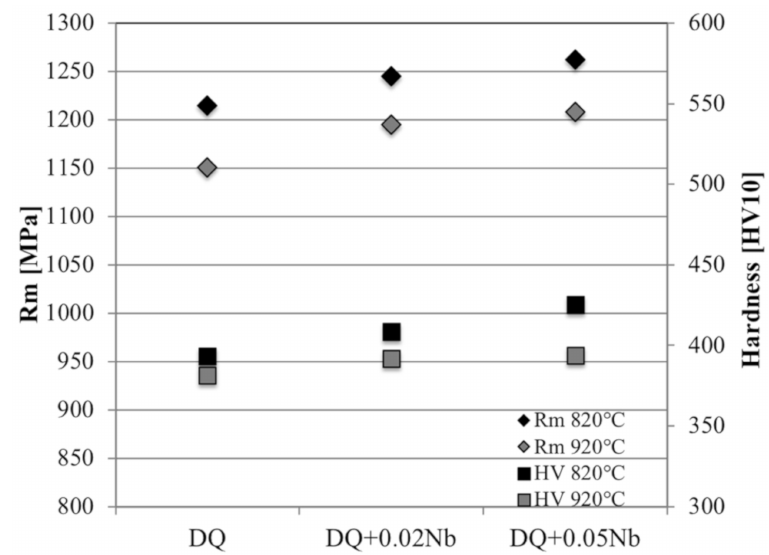
Figure 14. Tensile strength and mid-thickness Vickers hardness (HV10) values of investigated steels.